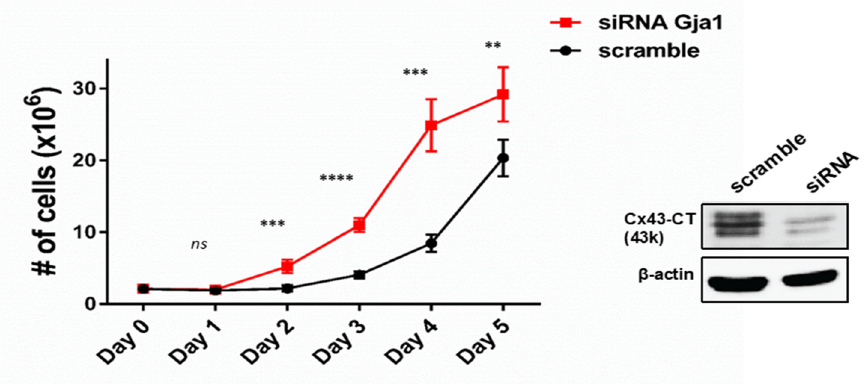
Figure 3: Effect of Cx43 on cell proliferation. The knockdown of endogenous Cx43 increases the cell proliferation of HEK293FT cells. For each day, data are presented as mean ± SEM, n = 9, ** p < 0.01, *** p < 0.001, **** p < 0.0001 by an unpaired two-tail Student’s t test. Western Blot analysis confirmed the knockdown of Cx43 and is representative of three independent experiments.